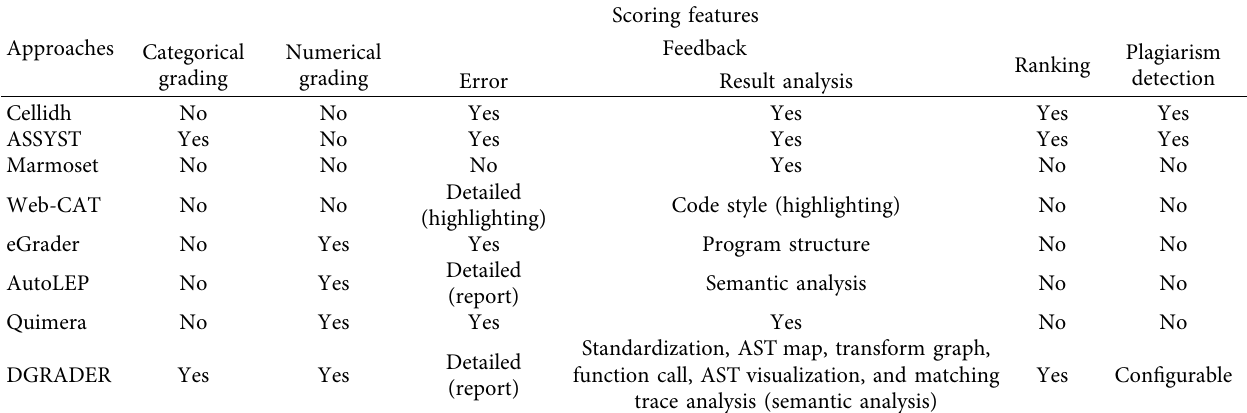
Table 13: Existing similar program comparison (scoring